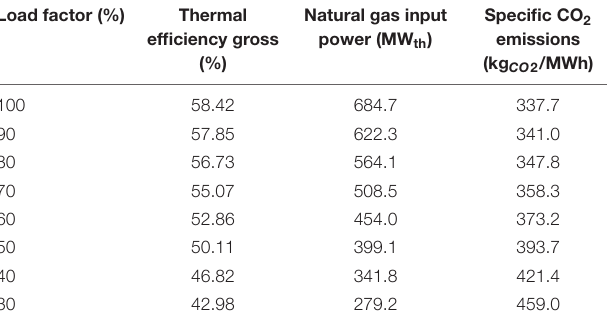
TABLE 2 | Performance of a 400-MW e combined cycle power plant vs .